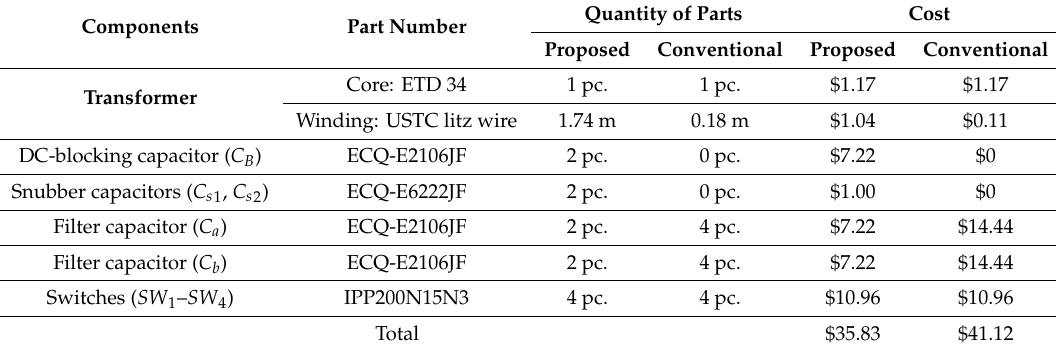
Table 5. Prices of components for the proposed and conventional CBB BDC .